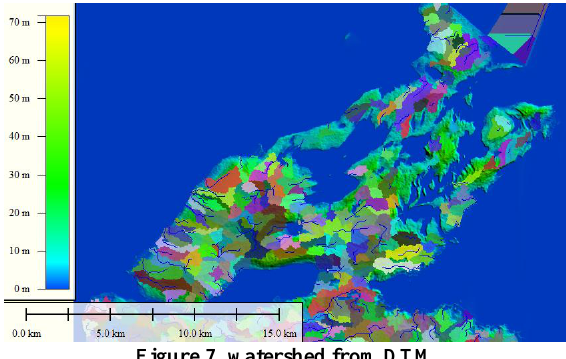
Figure 7. watershed from DTM